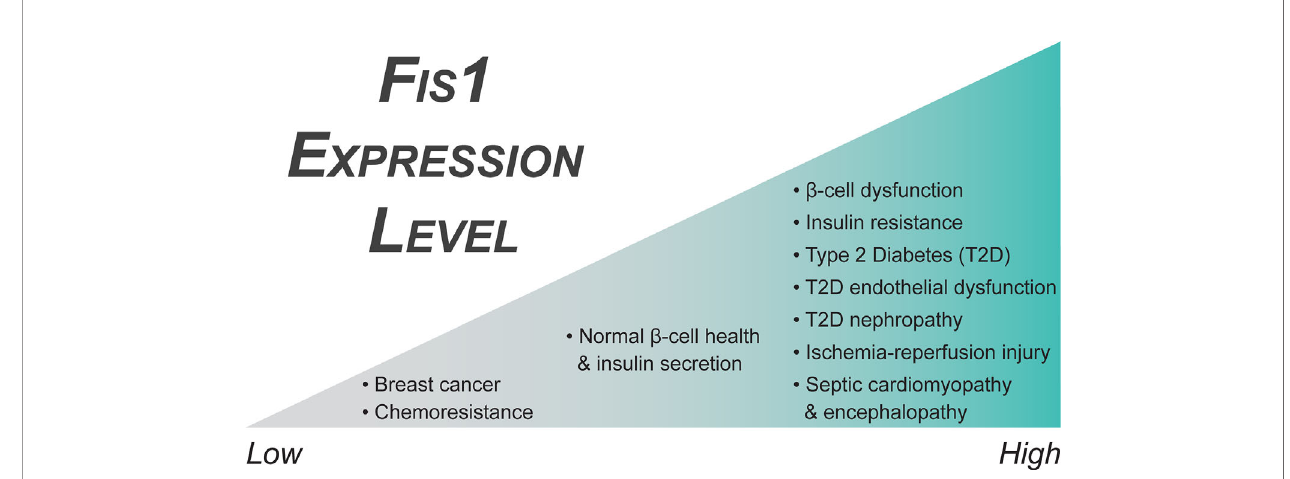
FIGURE 4 | Fis1 expression in endocrine related diseases. Fis1 expression levels vary from abnormally low to high in different diseases, potentially impacting overall mitochondrial and cellular